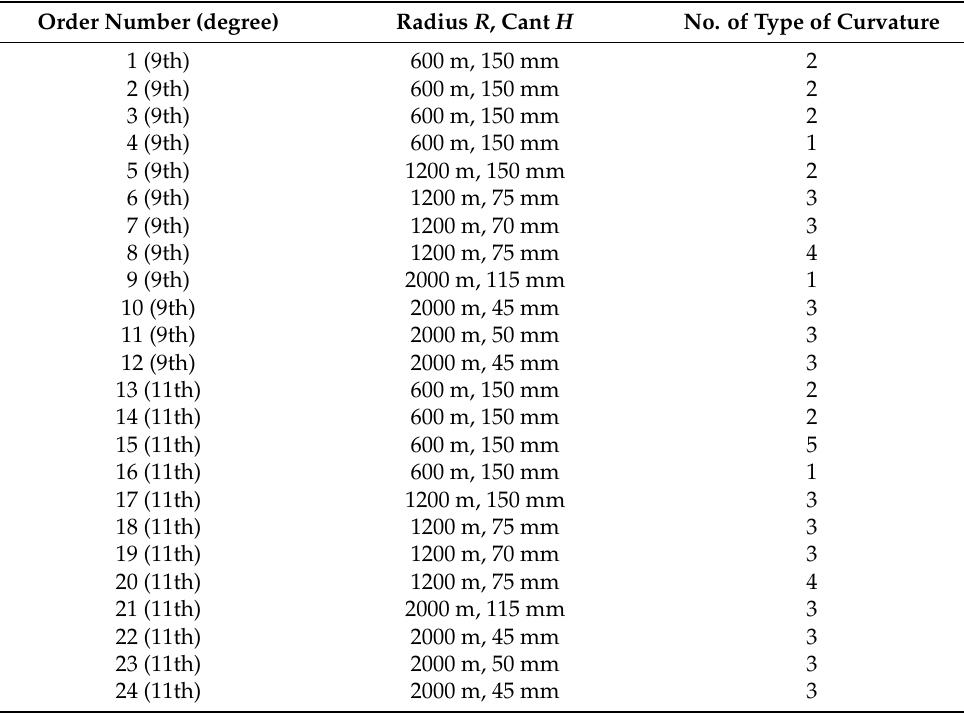
Table 2. The results of the optimization for 9th and 11th degrees.